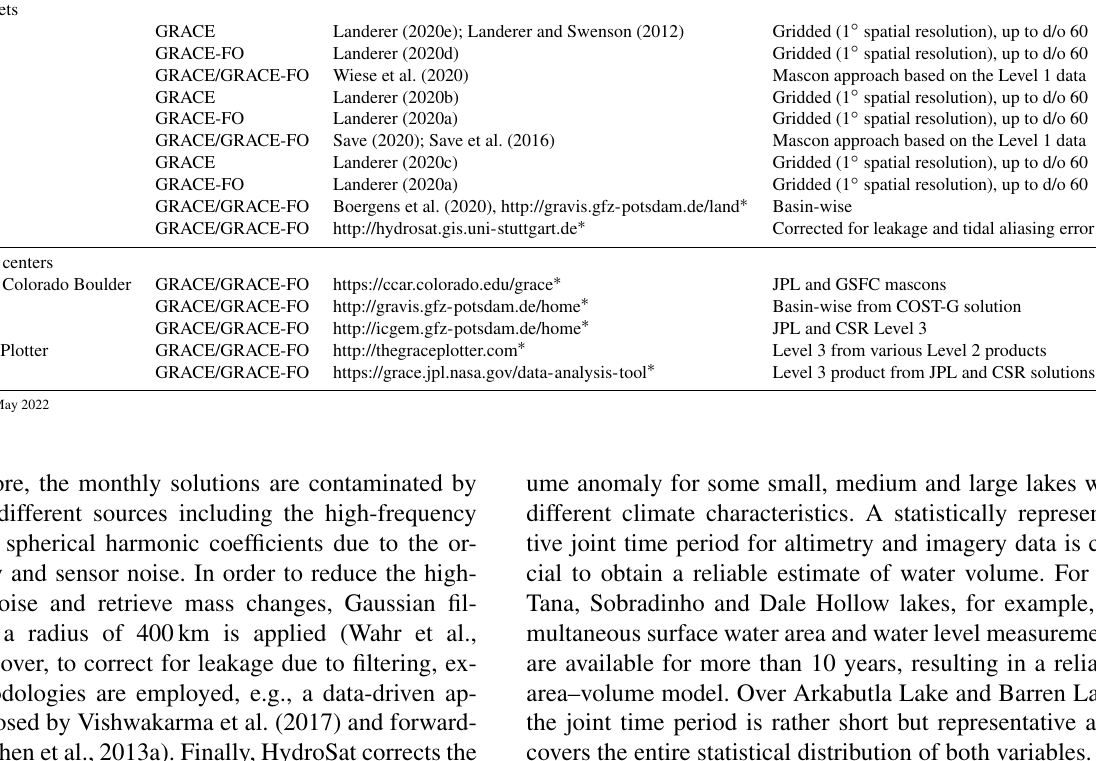
Table 3. List of centers which provide Level 3 TWSA from GRACE and GRACE-FO; d/o: degree and order.